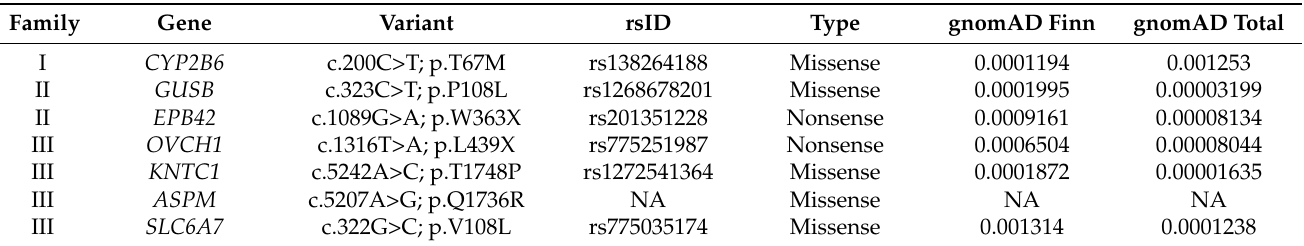
Table 1. Variants segregating with Ménière’s disease in families I–III.